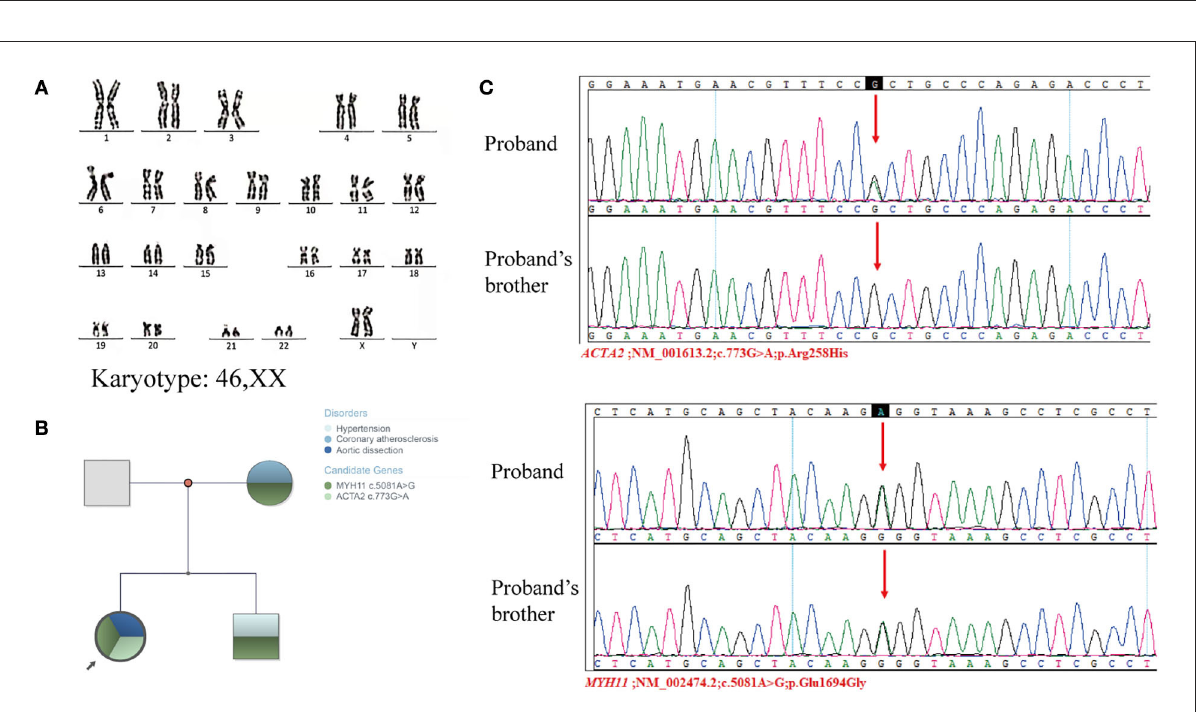
FIGURE2 Genetic examination of the proband and proband’s families. (A) Karyotyping analyses revealed a normal 46,XX karyotype. (B) Family tree. (C) Sanger sequencing validated the mutation of ACTA2 c.773G > A and MYH11 c.5081A > G in the proband and her